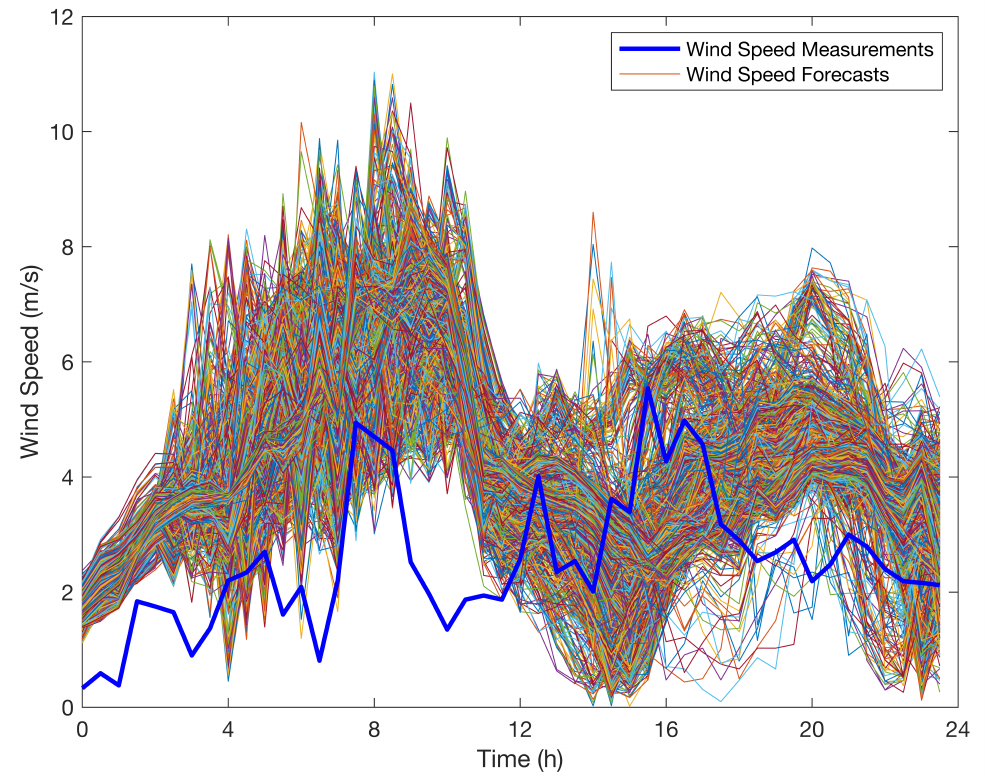
Figure 7. Comparison of the wind speed forecasts provided by the 1334 different WRF models and the historical wind speed measurements obtained on 11 August 2015 (the first day of the training